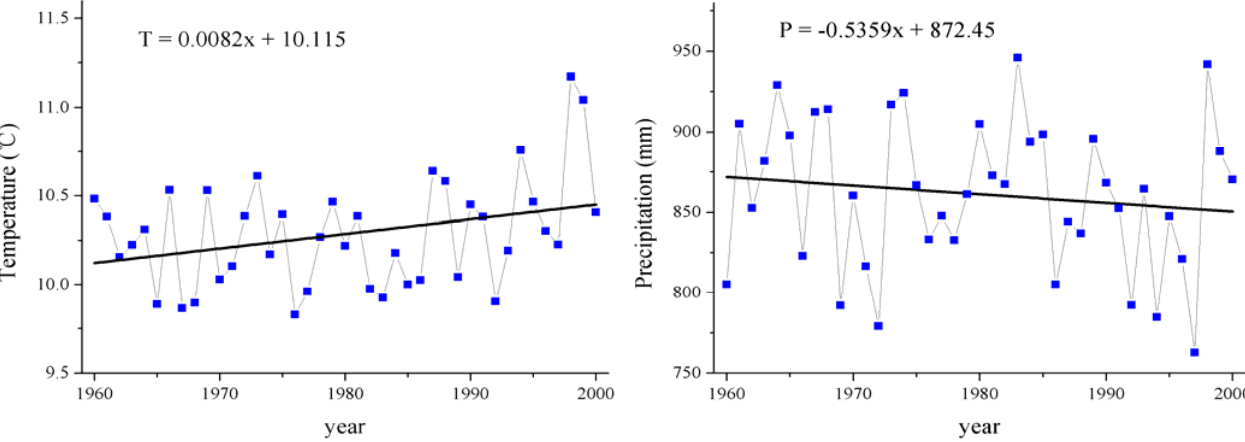
Figure 3. Climatic changes in the upper reaches of the Yangtze River during